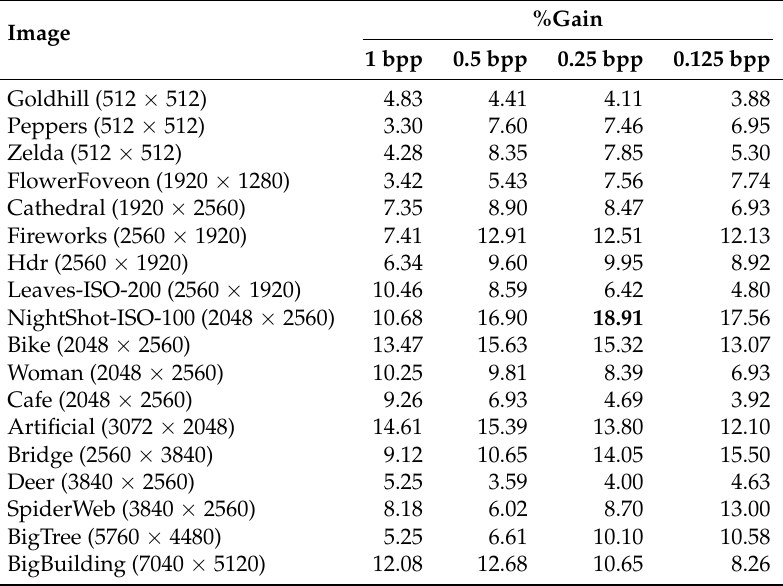
Table 5. Sign-compression performance at different bit rates for S-LTW